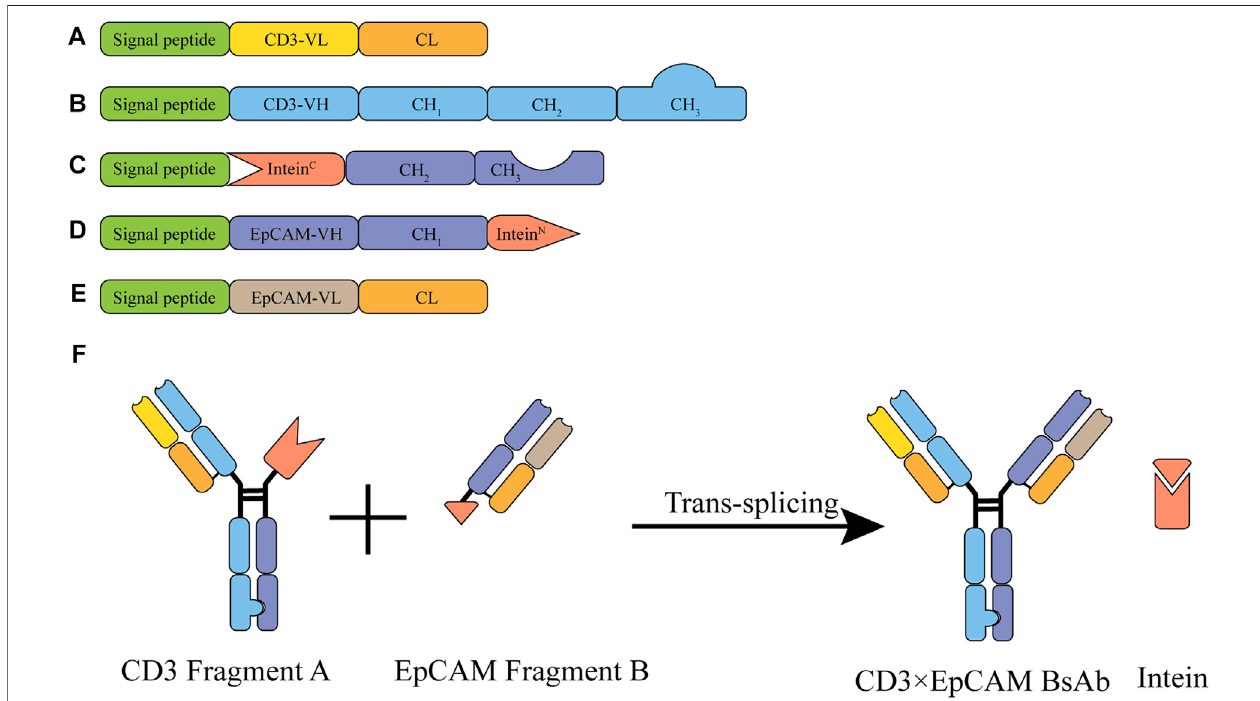
FIGURE1| IllustrationoftheCD3×EpCAMBsAbbispeci fi cantibodygeneratedbyBAPTSplatform. (A) CD3variableandconstantdomainsfortheCD3lightchain. (B) CD3 variable and constantdomains for theCD3heavychain. (C) CH2 andCH3 fusedwith Intein C for Int c Fc chain. (D) EpCAMvariable domain fused withInteinNfor HN chain. (E) Variable and constant domains for the EpCAM light chain. (F) Schematic illustration of CD3×EpCAM BsAb generated by BAPTS platform.